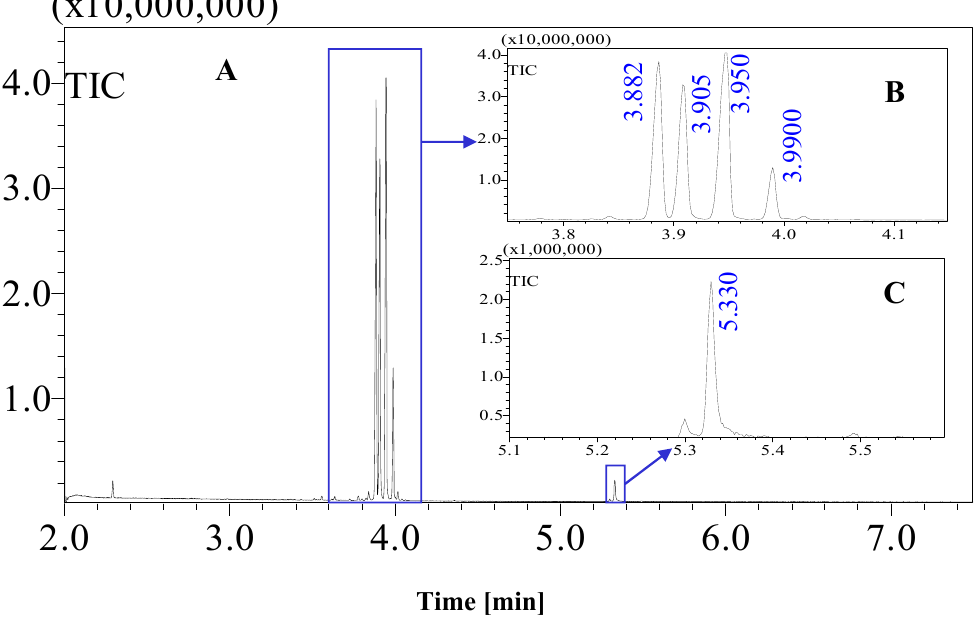
Figure 1. Total ion chromatogram (TIC) of an oximated-silylated date juice sample. Several peaks were obtained at different retention times (e.g., 2.3, 3.88, 3.905, 3.95, 3.99, 5.3 and 5.33 min). ( A ) Whole date juice chromatogram for a 7-min measurement; ( B ) the date juice chromatogram from 3.8–4.1 min; ( C ) the date juice chromatogram from 5.1–5.5 min.